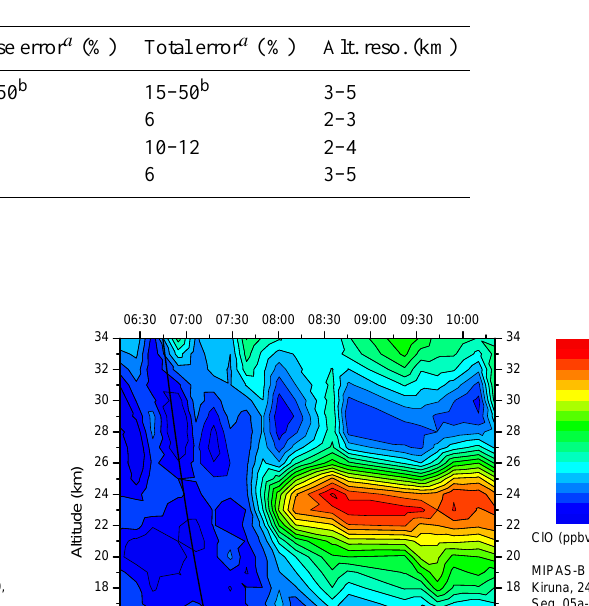
Table 1. Set-up for MIPAS-B trace gas retrievals and typical errors. Results are given for different state parameters in corresponding spectral windows together with the retrieval altitude resolution (Alt. reso.).